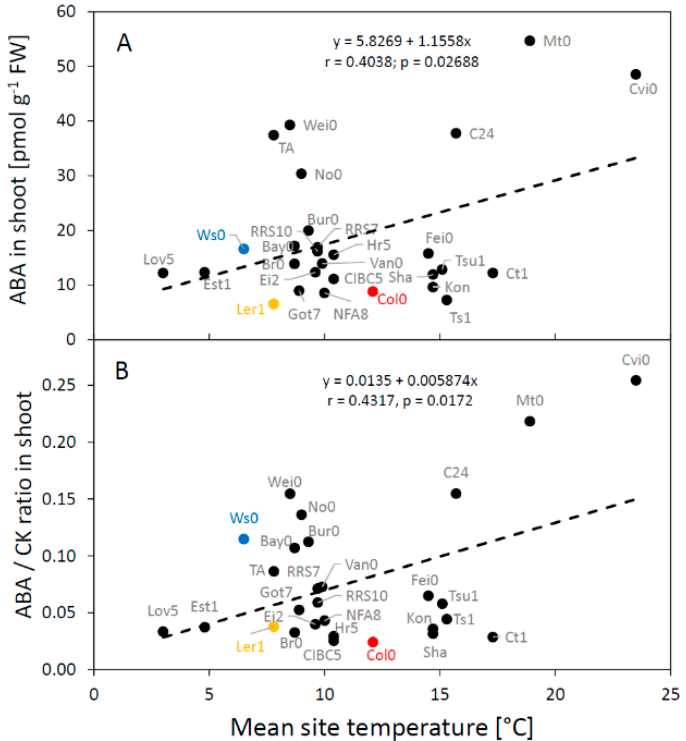
Figure 5. The ratio of total CKs to ABA in the shoot ( A ) and root ( B ) ranked from the lowest to the highest among thirty A. thaliana ecotypes grown 21d in controlled conditions. Commonly used ecotypes are marked in colour (Red = Col-0, Blue = Ws-0, Orange = Ler-1). See Table 1 for full list of ecotypes.